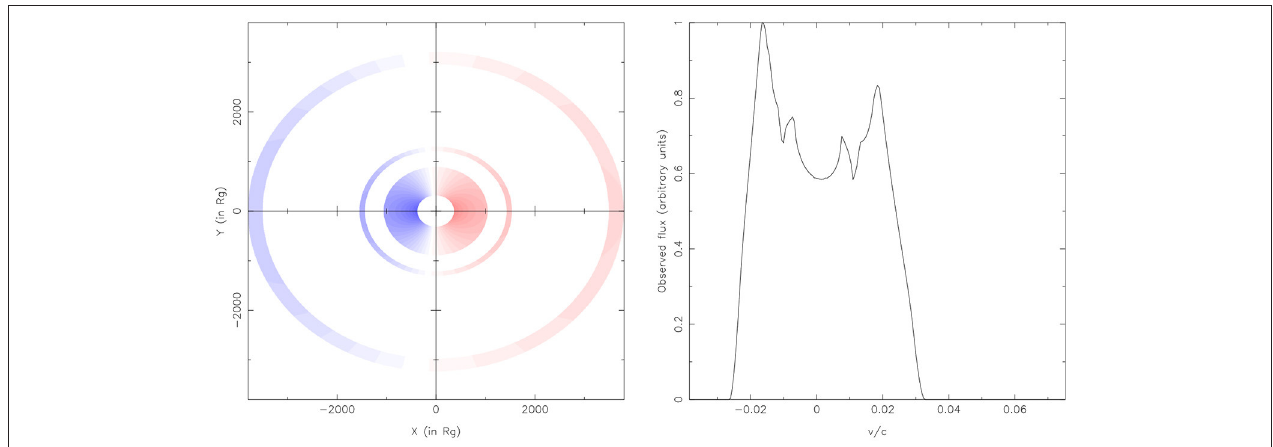
FIGURE 1 | An examples of AD 2 outer rings (left panel) with corresponding shape of broad line profile, matched to H α line of Arp 102B in +